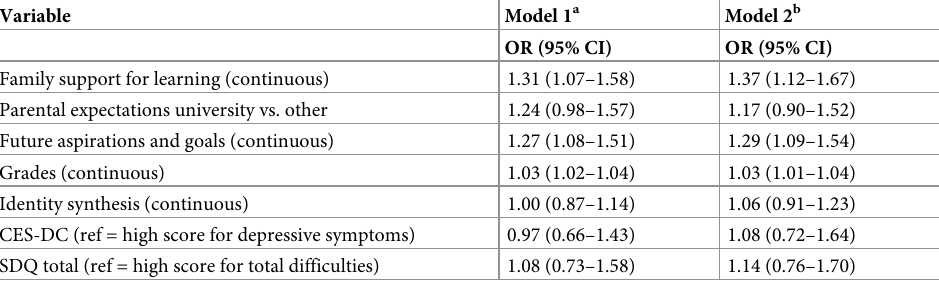
Table 3. Odds ratios and 95% confidence intervals for transition to definite expectations between 7 th and 9 th grade among adolescents who reported no definite expectations at baseline, according to family and individual predictors (N = 1,429).